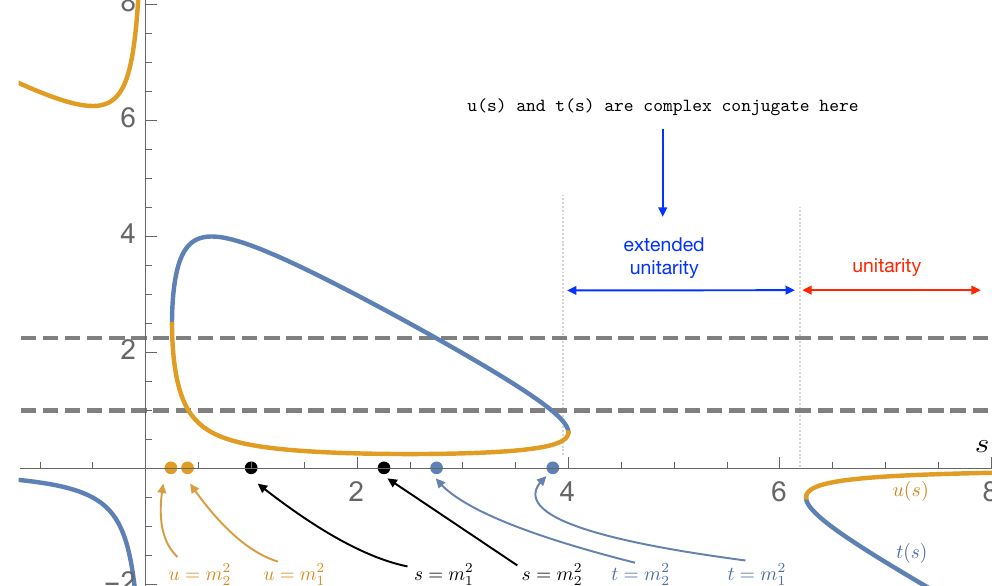
Figure 4 . t ( s ) (blue) and u ( s ) (yellow) for 11 → 12 scattering and m 2 = 3 m 1 . u ( s ) and t ( s ) are 2 two branches of the same analytic function. In the extended unitarity region they are complex. As a function of s , all poles are located before the extended unitarity region. The grey horizontal dashed lines are equal to m 2 and m 2 and fix the position of the t – and u – channel poles. 1 2